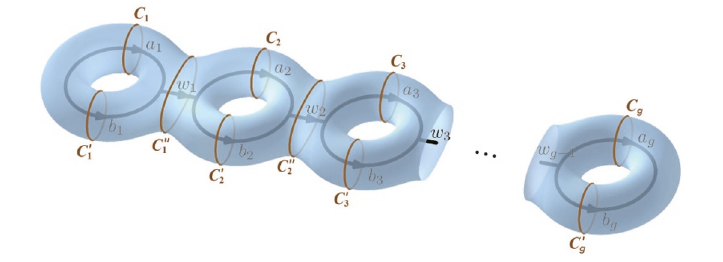
Figure 9 . The Dehn twists along the loops C 1 ; 2 ;:::;g , C 0 the states jf a i g ; f b i g ; f w i